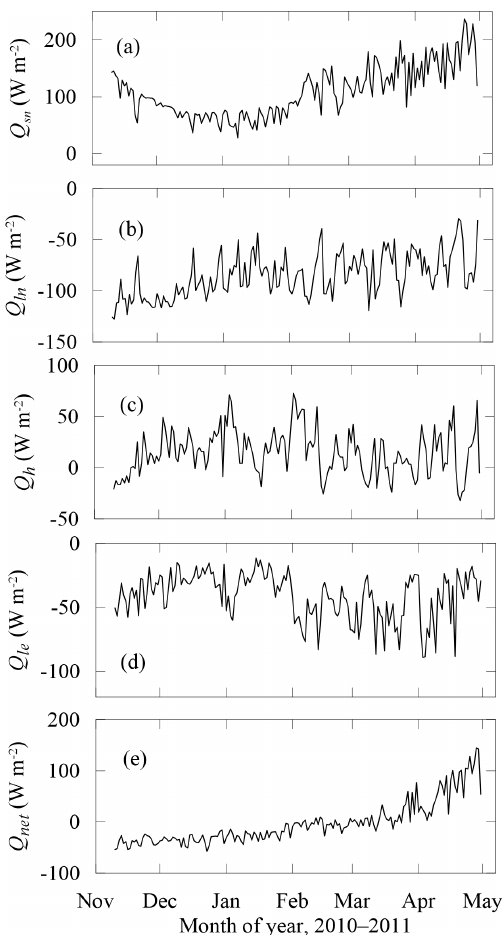
Figure 11. Daily means of the surface energy balance components of net short-wave ( Q sn ) and long-wave ( Q ln ) radiation, turbulent sensible ( Q h ) and latent ( Q e ) heat fluxes, and net flux into the lake ( Q net = Q sn + Q ln + Q h + Q le ) through the entire ice season.